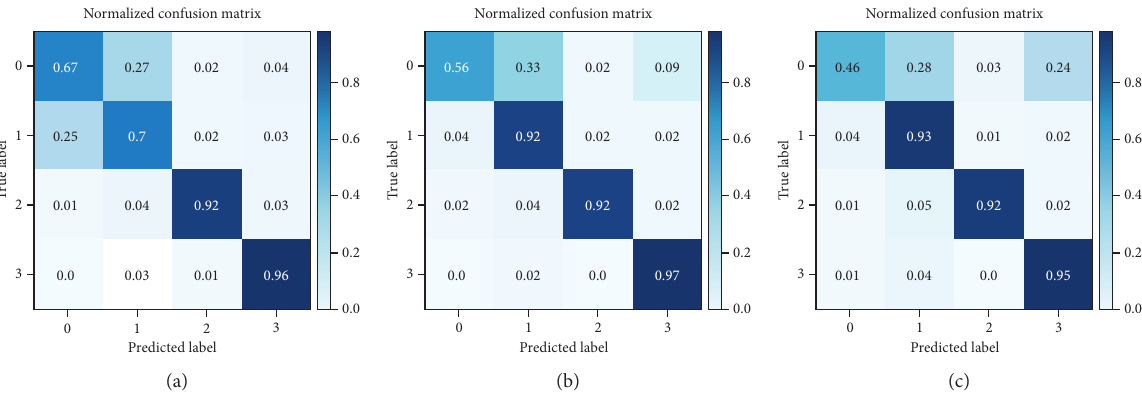
Figure 9: Confusion matrix of three gait patterns derived from GFM-Net classification under three paces. Settings: 0.78m/s (a), 1.0 m/s (b), and 1.25m/s